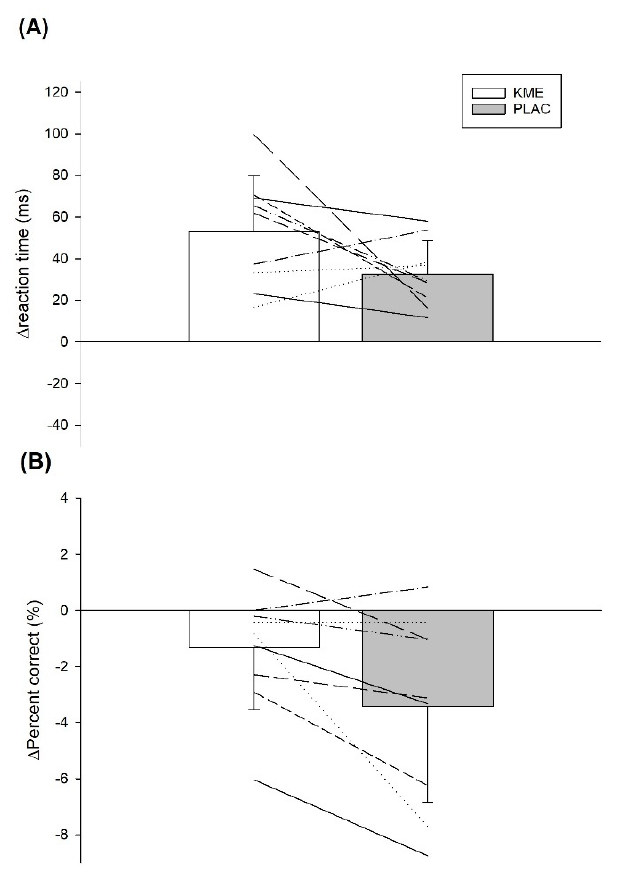
Figure 4. Effects of KME supplementation on cognitive function (CRT) during exercise after induced mental fatigue, compared to PLAC. ( A ) reaction time during exercise, relative to pre-exercise (Post MFT) ( B ) %correct answers during exercise, relative to pre-exercise (Post MFT). Values are means ± SD. Thin lines indicate individual participant data. MFT = mental fatiguing task; KME = ketone monoester supplement; PLAC = non-caloric placebo.